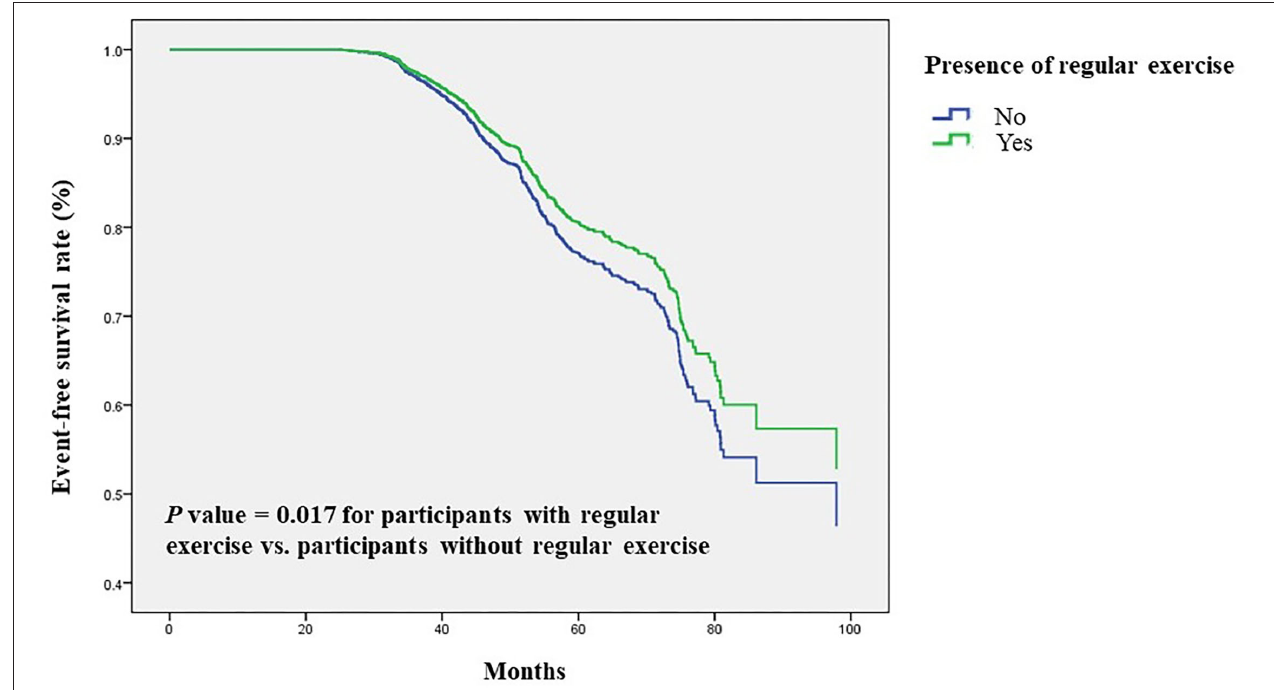
FIGURE 2 | Time to osteoporosis development was longer in participants with regular exercise than in participants without regular exercise. Kaplan-Meier plot of incident osteoporosis development according to the presence of regular exercise in 6,785 participants with follow-up data.